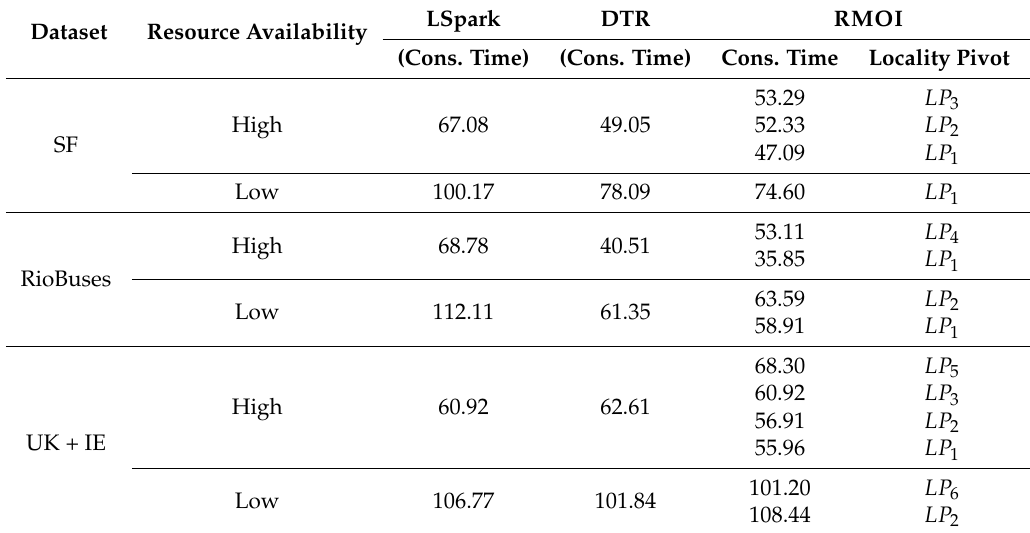
Table 2. The construction time (in seconds) for LSpark, DTR, and RMOI, where LP x means LP = x